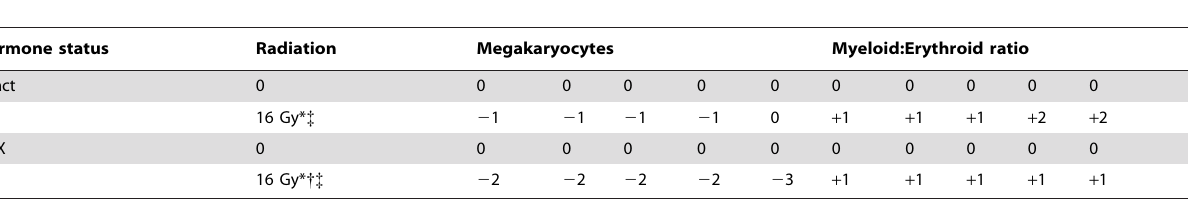
Table 4. Megakaryocyte number and myeloid: erythroid ratio in intact (I) and ovariectomized (OVX) mice receiving either 0 ( 2 R) or 16 Gy radiation ( + R) 30 days